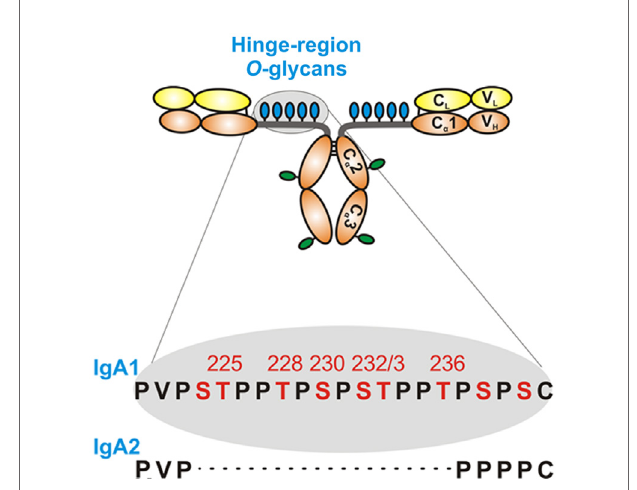
FiGURe 2 | Hinge-region glycosylation of human igA1 and comparison of amino-acid sequences of human igA1 and igA2 . Human IgA1 has nine Ser (S) and Thr (T) amino-acid residues in the hinge-region segment (between constant regions C1 and C2 of the heavy chains). Usually, three to six clustered O -glycans are attached per hinge region. IgA2 hinge region is shorter compared to that of IgA1, does not have Ser and Thr residues and, thus, IgA2 does not have O -glycans. Moreover, each IgA1 heavy chain has two N -glycans, one in the C2 domain and the second in the tailpiece portion of the C3